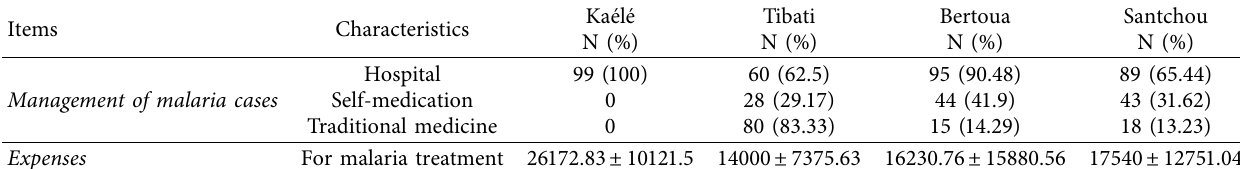
Table 5: Home management of malaria cases and financial cost of malaria treatment in Ka´el´e, Tibati, Santchou, and Bertoua.